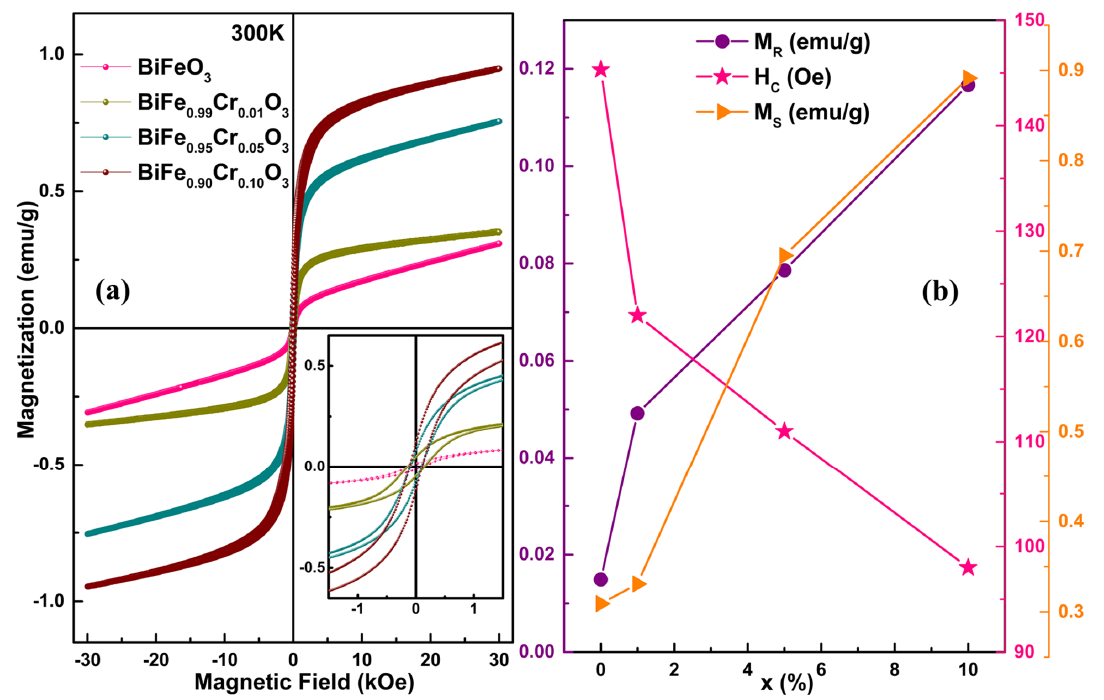
Figure 8. ( a ) Room temperature M–H hysteresis curves of BiFe 1-x Cr x O 3 (0 ≤ x ≤ 10) nanoparticles in the range ±30 kOe; inset shows the behavior of the curves near H = 0. ( b ) Variation in M R , Ms and Hc as functions of Cr concentration.